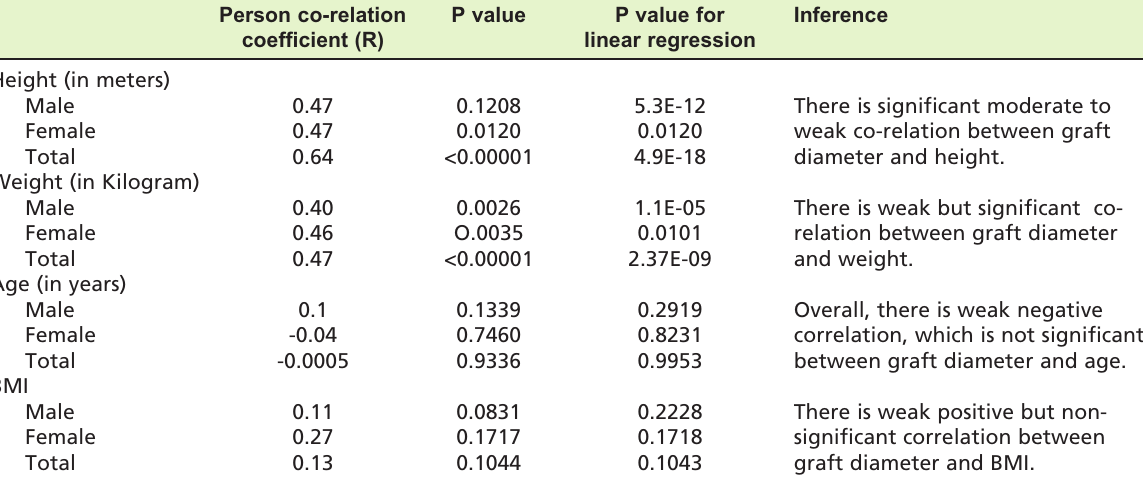
Correlation between graft diameter ( GD) with parameters Table III: